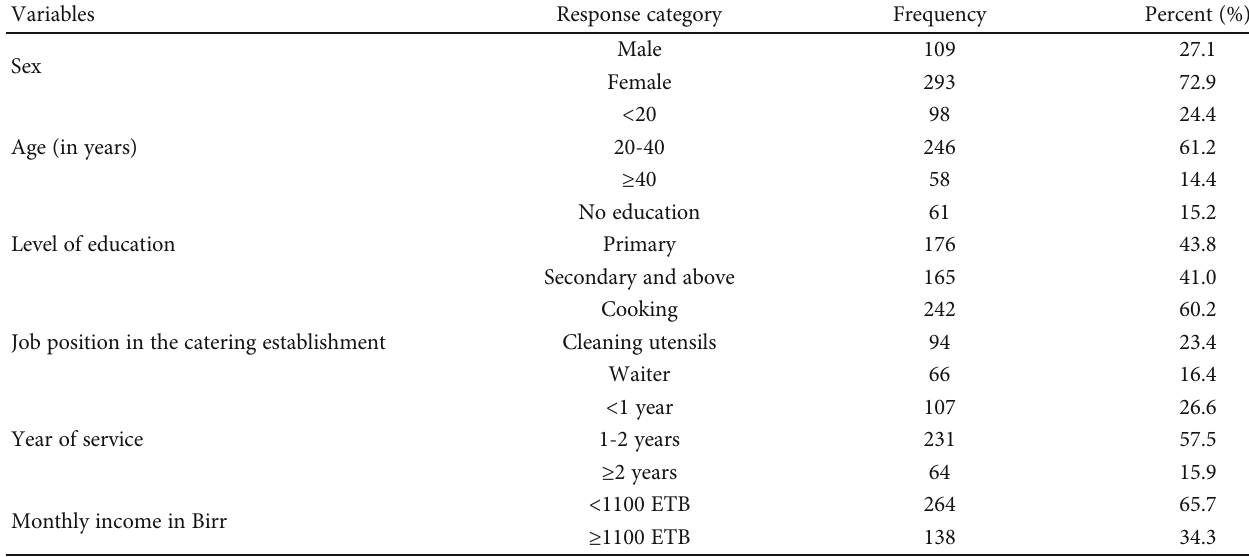
Table 1: The sociodemographic characteristics of food handlers working in catering establishments in Dawuro Zone, South-Western Ethiopia, March to July 2019 ( N = 402 ).